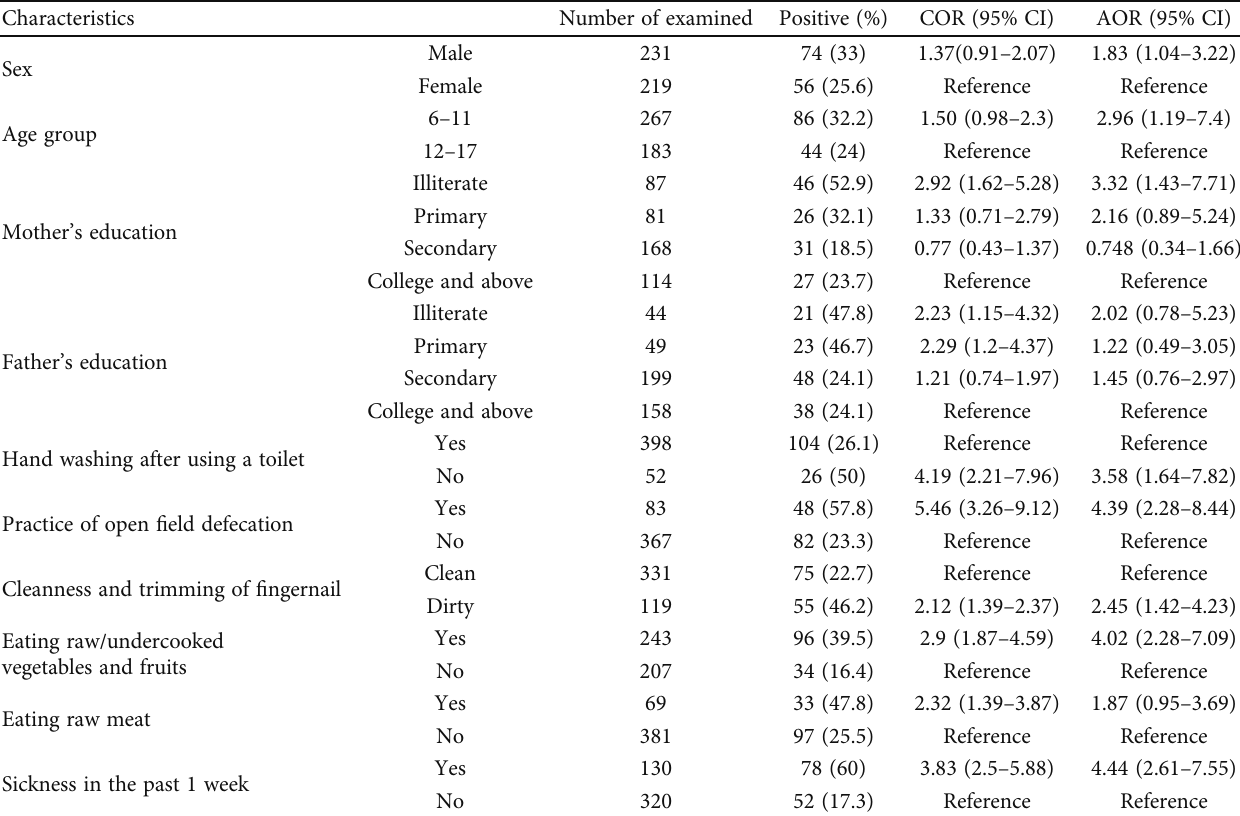
Table 5: Factors associated with the prevalence of IPIs among primary school children in Dessie, North-central Ethiopia, 2021. Characteristics